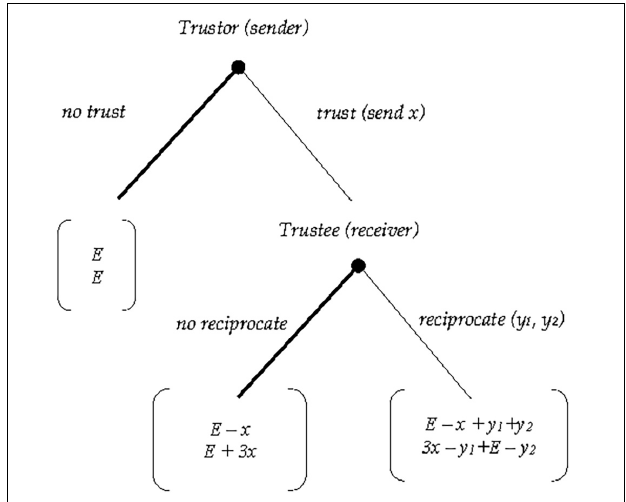
FIGURE 1 | Extensive form of the one-shot TG with fixed endowment.